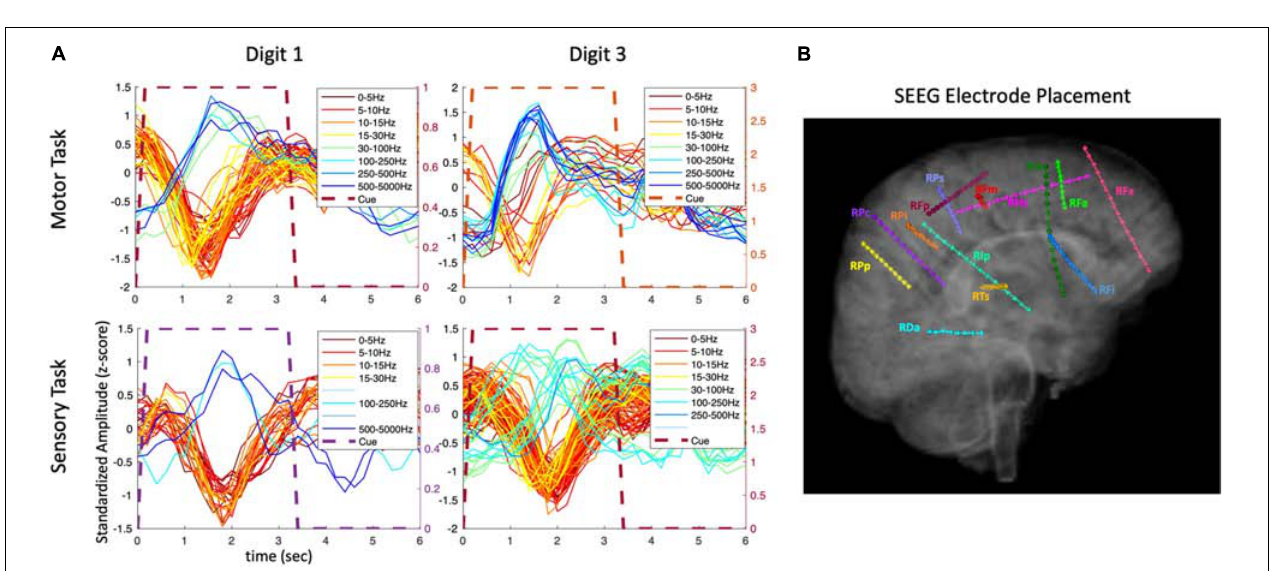
FIGURE 3 | Predominantly phasic neural activity for sustained hand and finger movements in SEEG and ECoG recordings. Representative set of composite temporal responses across three study participants and different hand and finger movements are shown. In both the SEEG (depth) and HD ECoG (surface) recordings, the responses across a wide range of frequency bands are predominantly phasic in nature. The MCC (repeatability metric) was greater than 0.6 for all plots in this figure except in P1_02 where it was 0.5 for “Close hand (SEEG)” and 0.4 for “Thumb Flexion (HD ECoG).”